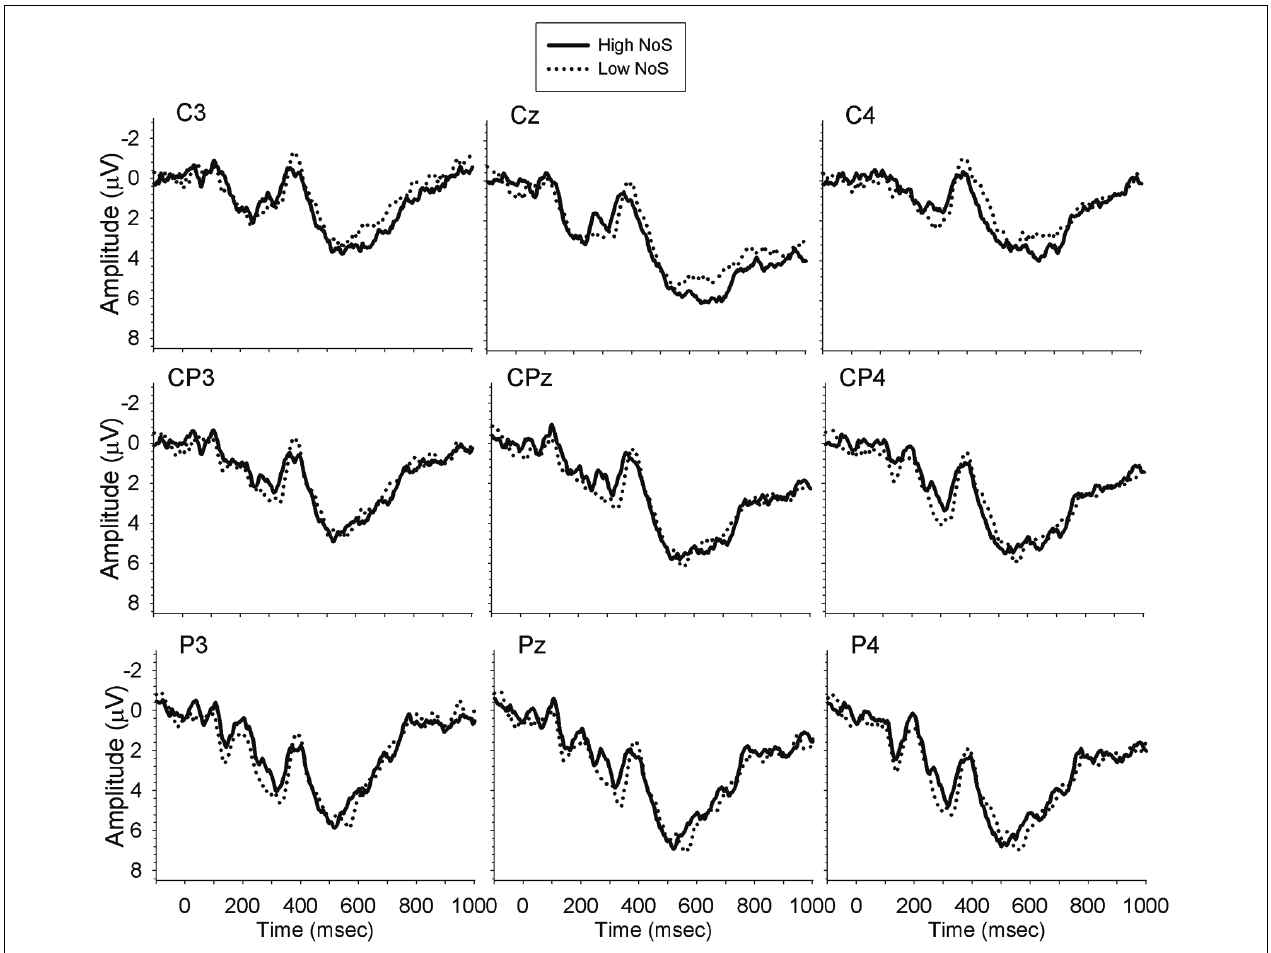
FIGURE 2 | Waveforms elicited by bilinguals performing the task in